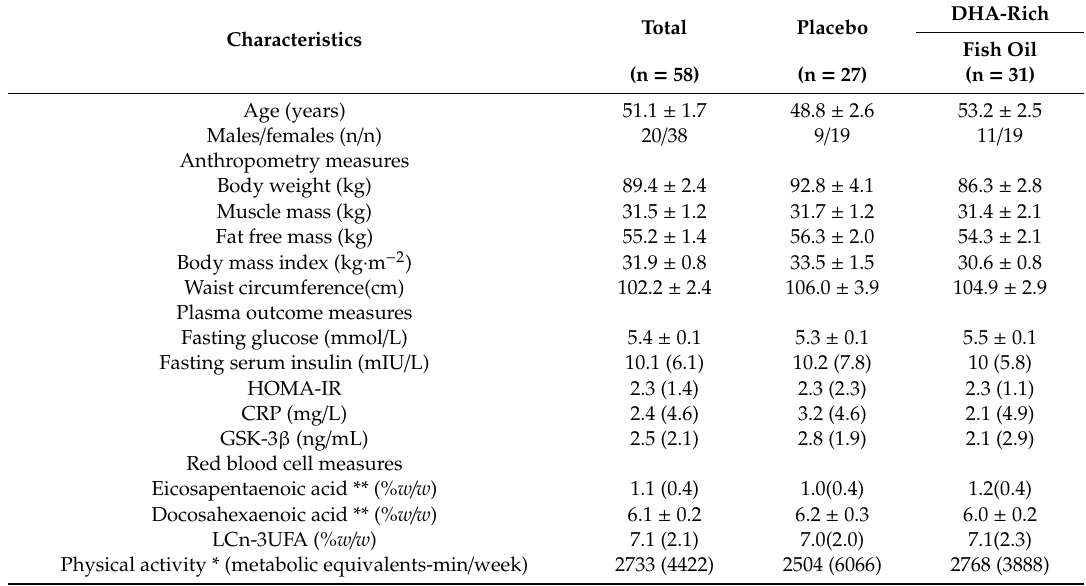
Table 1. Baseline characteristics of the study